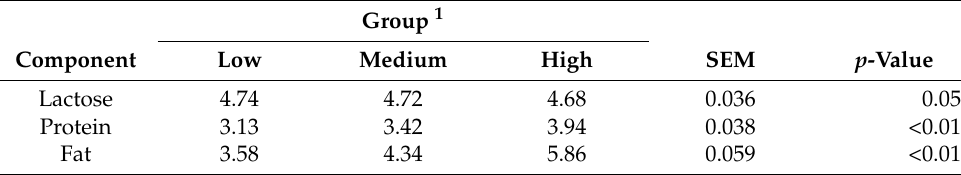
Table 5. Content of milk components by milk energy (low, medium, and